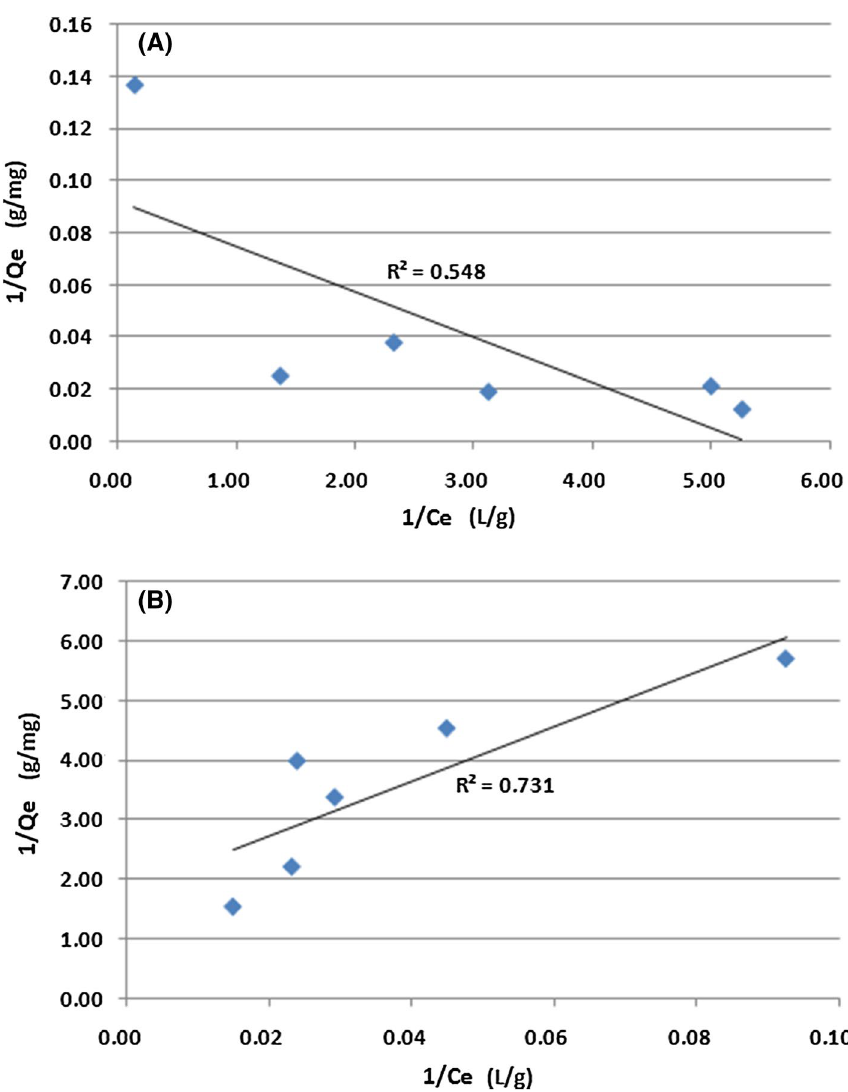
Fig. 5 Langmuir adsorption isotherm for Sm 3+ by pre- treated Bacillus subtilis cells. a NaOH pre-treated cells, b HCl pre-treated